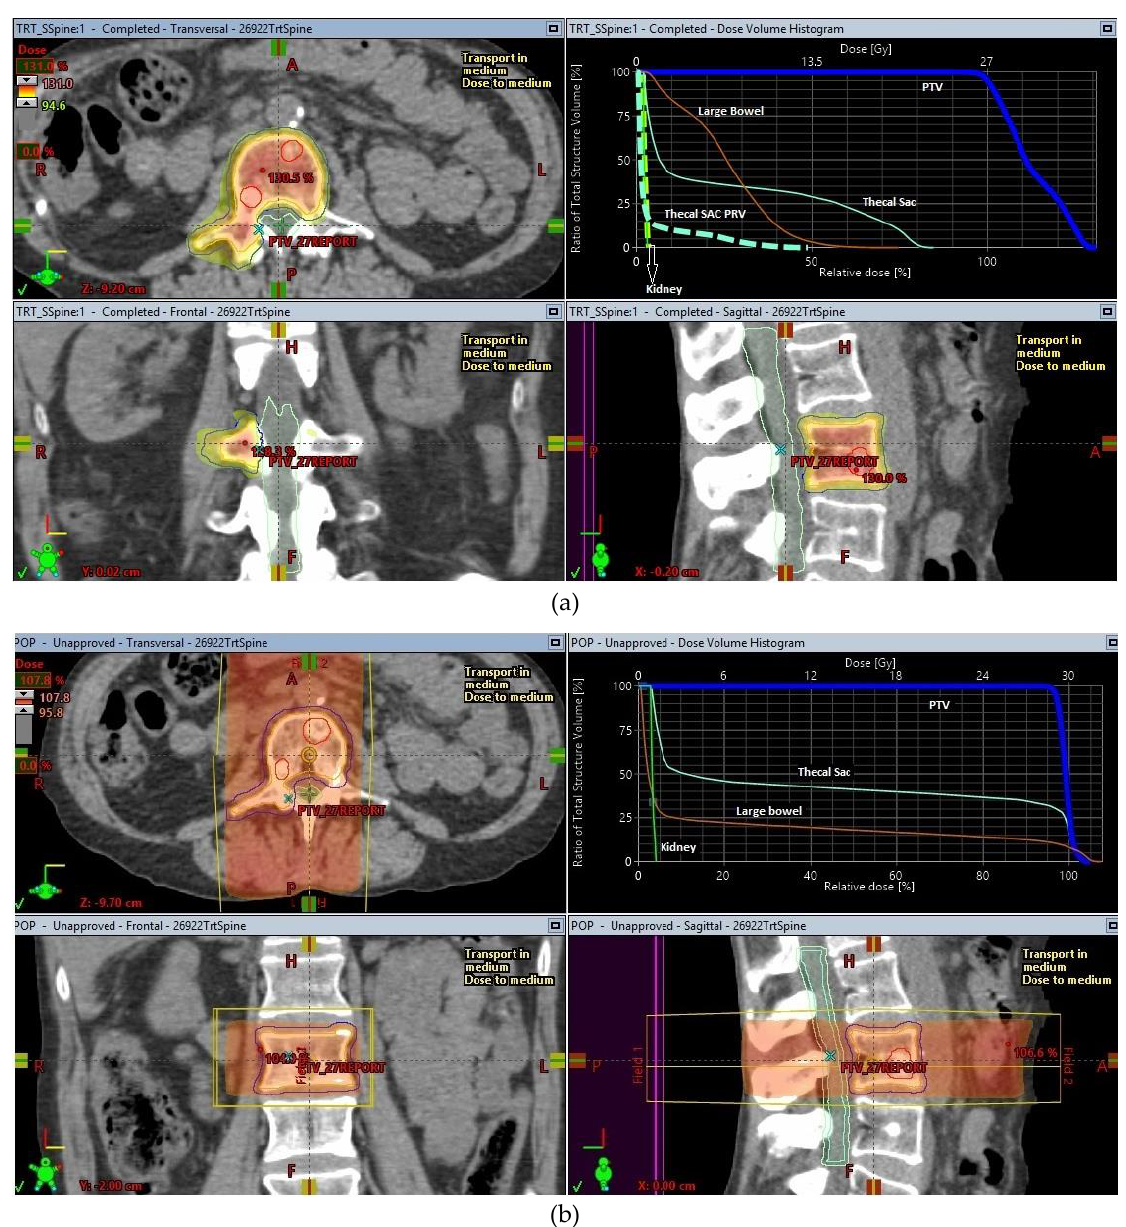
Figure 1. SBRT and conventional treatment plans for a lumbar spine oligometastases. ( a ) SBRT plan for lumbar spine oligometastasis, ( b ) Conventional radiotherapy plan for lumbar spine oligometastasis.